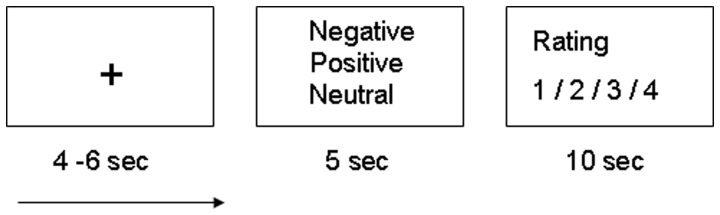
Schematic depiction of a single trial in the mental state discrimination paradigm.Each 25-s trial consisted of a 4–6 fixation cross at the beginning and at the end, a 5-s presentation of a RMET-picture (negative/positive/neutral) and a 10-s rating period. During the rating period, subjects indicated the mental state/emotion of the person on the picture (using a 4-button hand pad in their right hand). 36 trials were presented. RMET, Reading Mind in the Eyes Test (20).